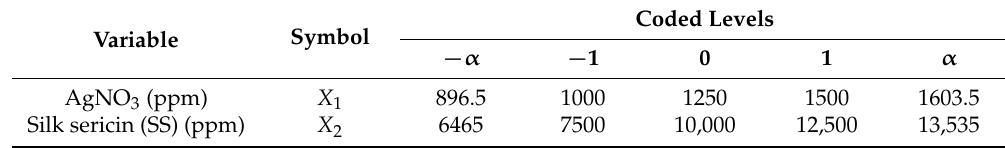
Table 1. Experimental range and coded levels of independent variable ( α =